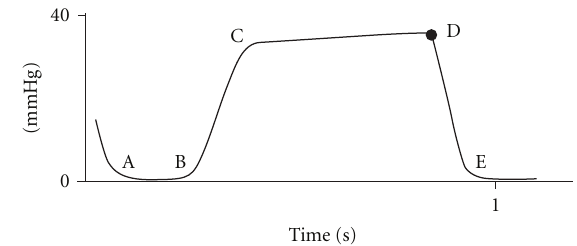
Figure 1: Analysis of the capnograph wave. A: End of inhalation; B: Beginning of exhalation; B–D: Exhalation of alveolar gas; D: End exhalation and point of maximal or highest CO 2 concentration { end-tidal CO } ; D-E: 2 (EtCO 2 )